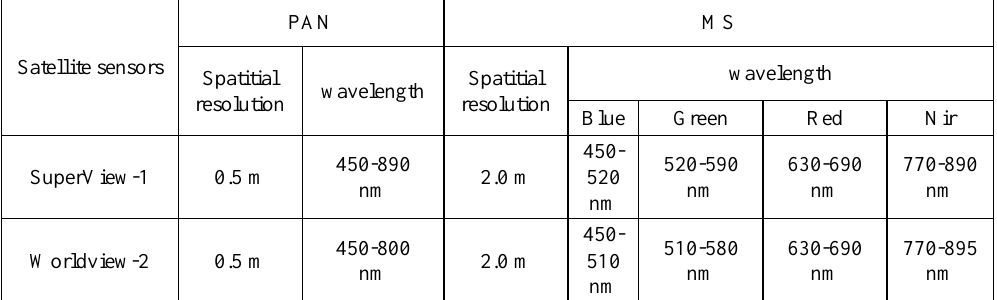
Table 1. Parameters of Satellite